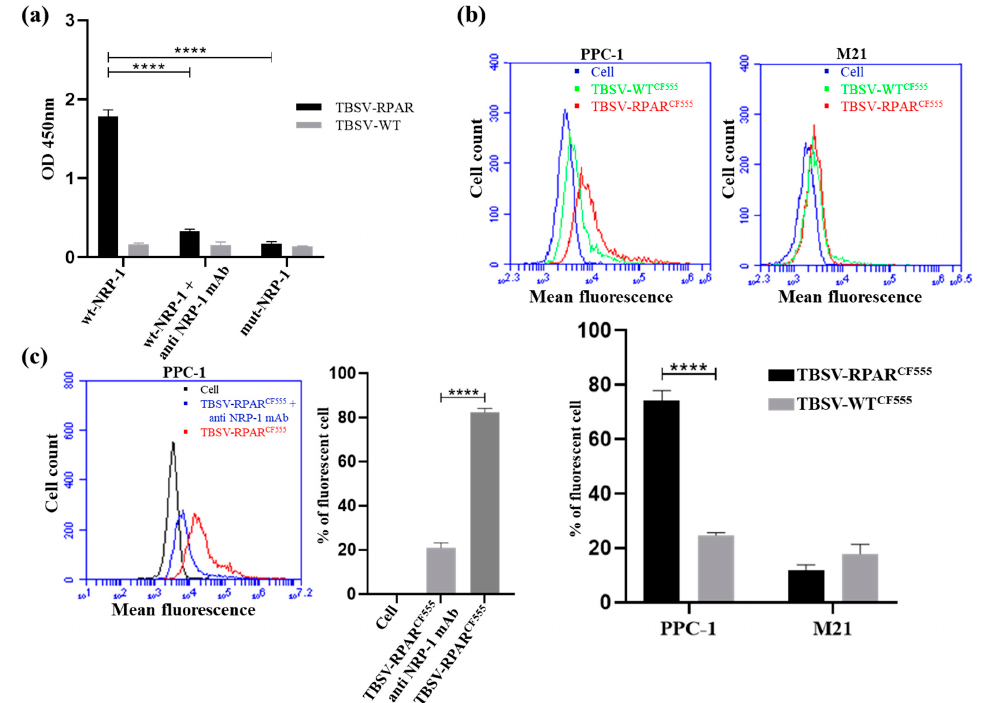
Figure 3. TBSV-RPAR NPs interact with recombinant NRP-1 and with cell surface NRP-1. ( a ) Binding of TBSV-RPAR and TBSV-WT to wt-NRP-1 or mut-NRP-1. TBSV detection using sandwich ELISA used primary rabbit anti-TBSV antibody followed by HRP-conjugated anti-rabbit antibody, followed by chromogenic reaction and quantitation of signal at 450 nm. CendR-blocking anti-NRP-1 antibody reduced TBSV-RPAR binding. **** p < 0.0001 Student’s t -test. ( b ) Flow cytometry of CF555-labeled TBSV-WT and TBSV-RPAR incubated with NRP-1-expressing PPC-1 and NRP-1-negative M21 cells. Cell count vs. mean fluorescence and percentage of fluorescent cells are shown. **** p < 0.0001. ( c ) Effect of anti-NRP-1 antibody on binding of CF555-labeled TBSV-RPAR to PPC-1 cells. Cell count vs. mean fluorescence and percentage of fluorescent cells after incubation with TBSV-RPAR CF555 are shown. **** p < 0.0001 Student’s t